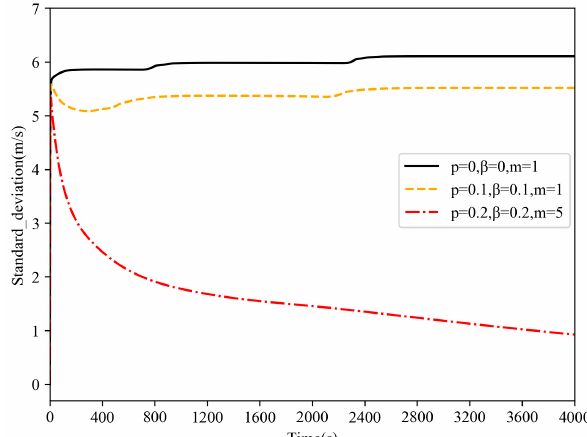
Figure 8. Evolution of the velocity standard deviation with large experimental scales.